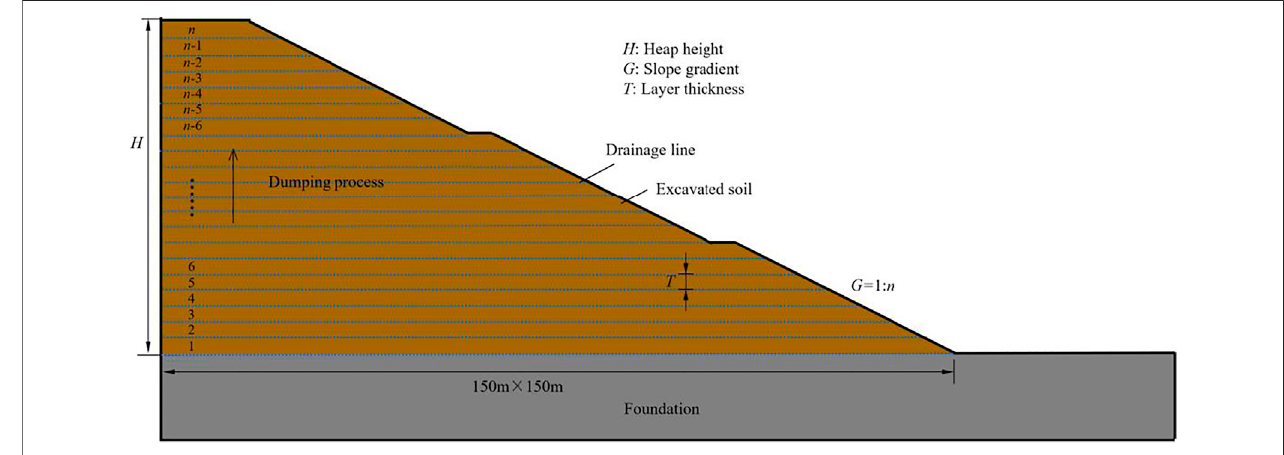
FIGURE 2 | Numerical model of the piled mountain pro fi le.